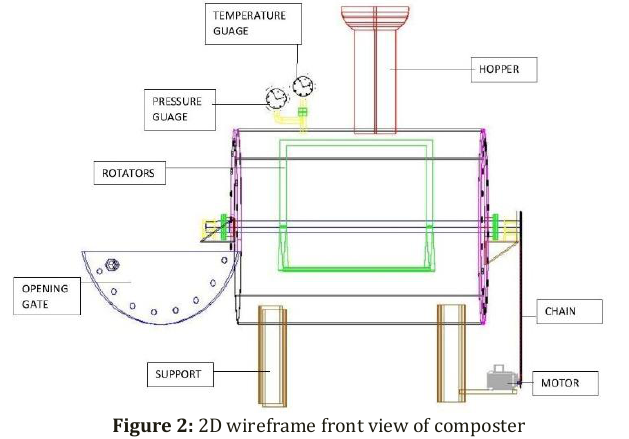
Figure 2: 2D wireframe front view of composter